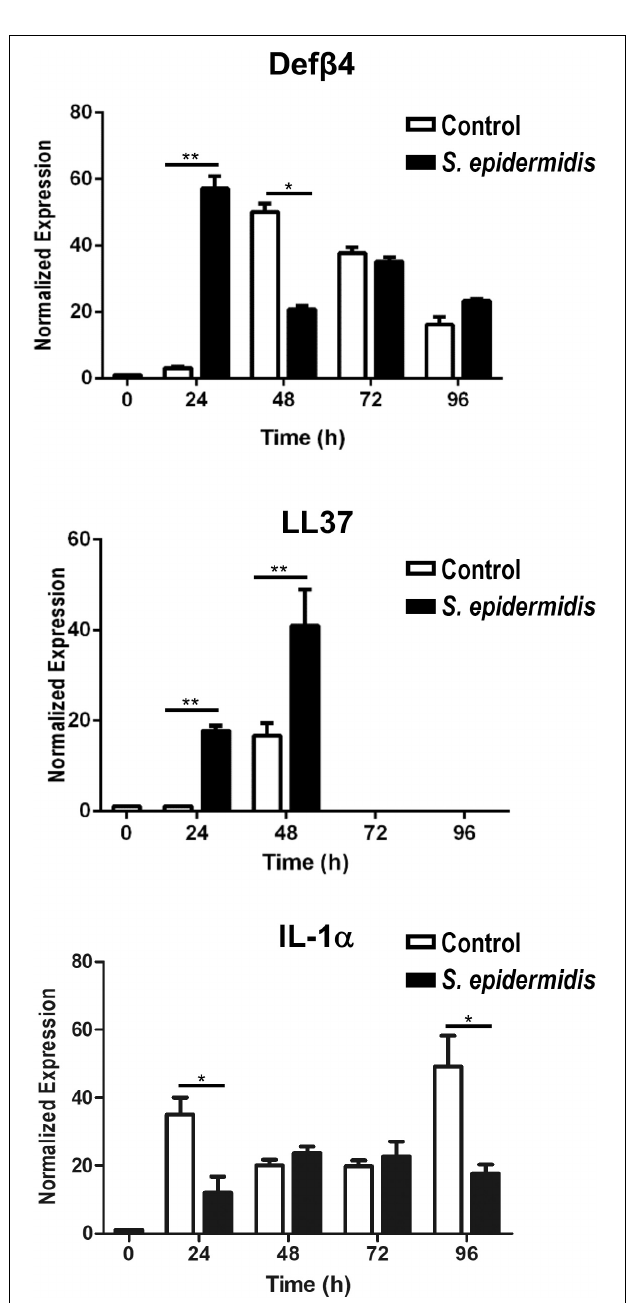
FIGURE 4 | Antimicrobial and inflammatory responses mediated by Staphylococcus epidermidis in human ex vivo model. Expression levels of antimicrobial peptides Def β 4, LL-37, and pro-inflammatory cytokine IL-1 α were evaluated by qPCR from non-colonized and S. epidermidis colonized skin at 24, 48, 72, and 96 h ( n = 3 for each treatment group and time point). * p < 0.05, ** p < 0.01 as calculated using Student t